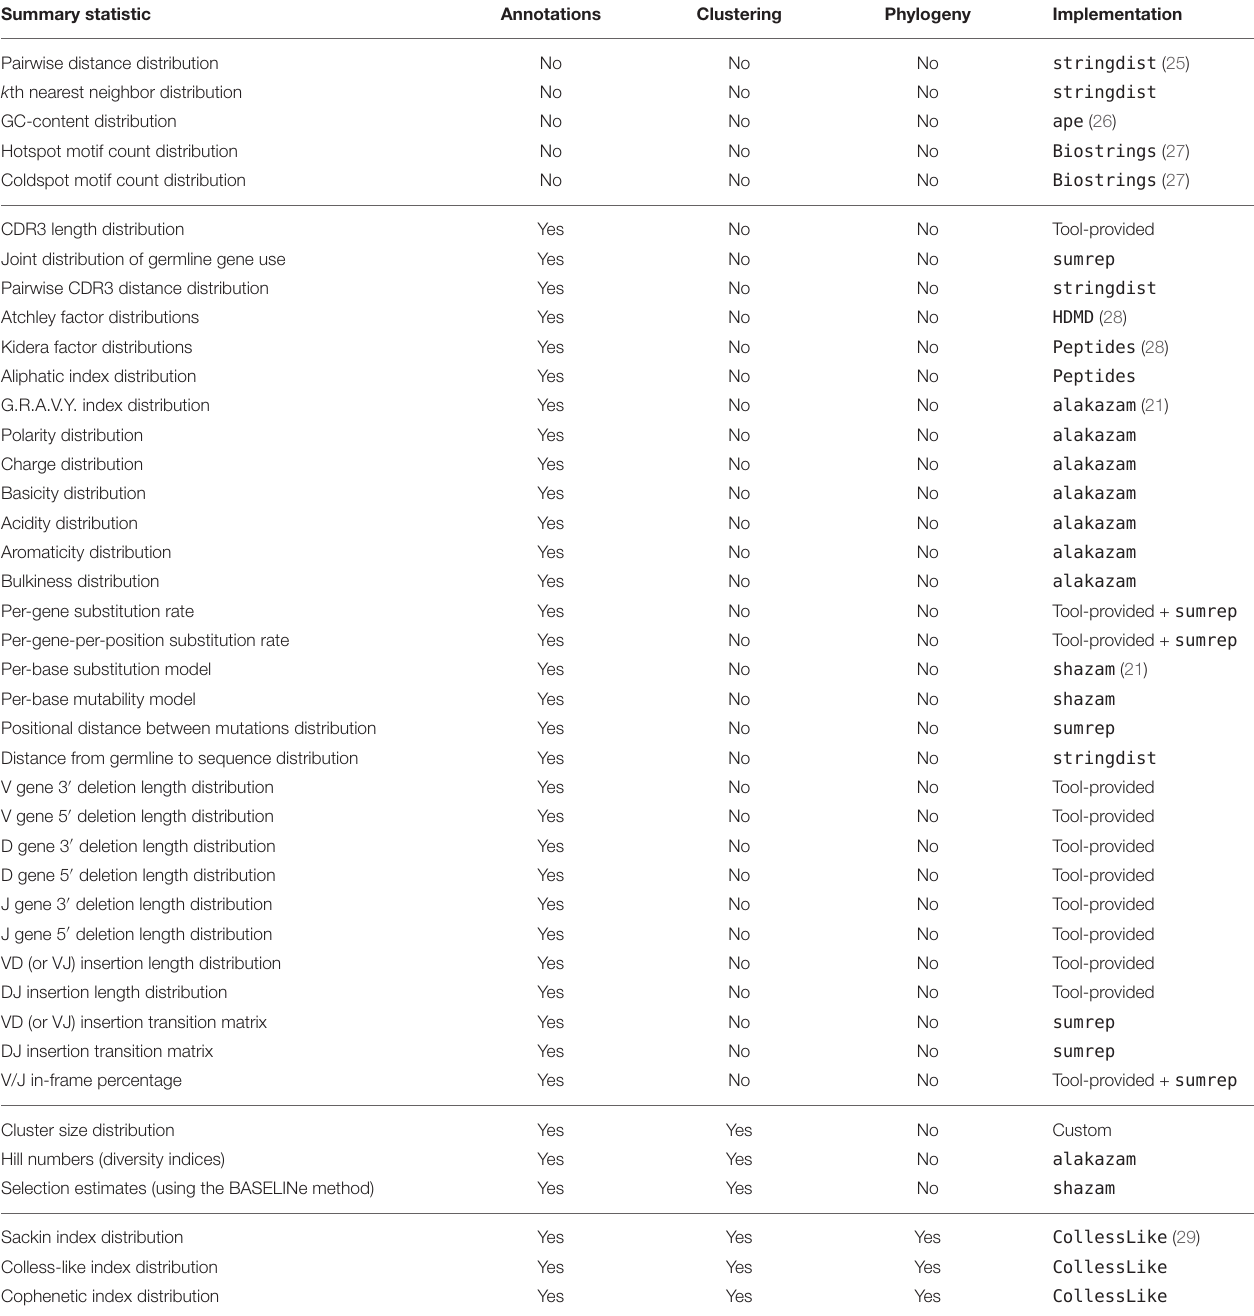
TABLE 1 | Currently supported summary statistics grouped by their respective degrees of assumed post-processing. Summary